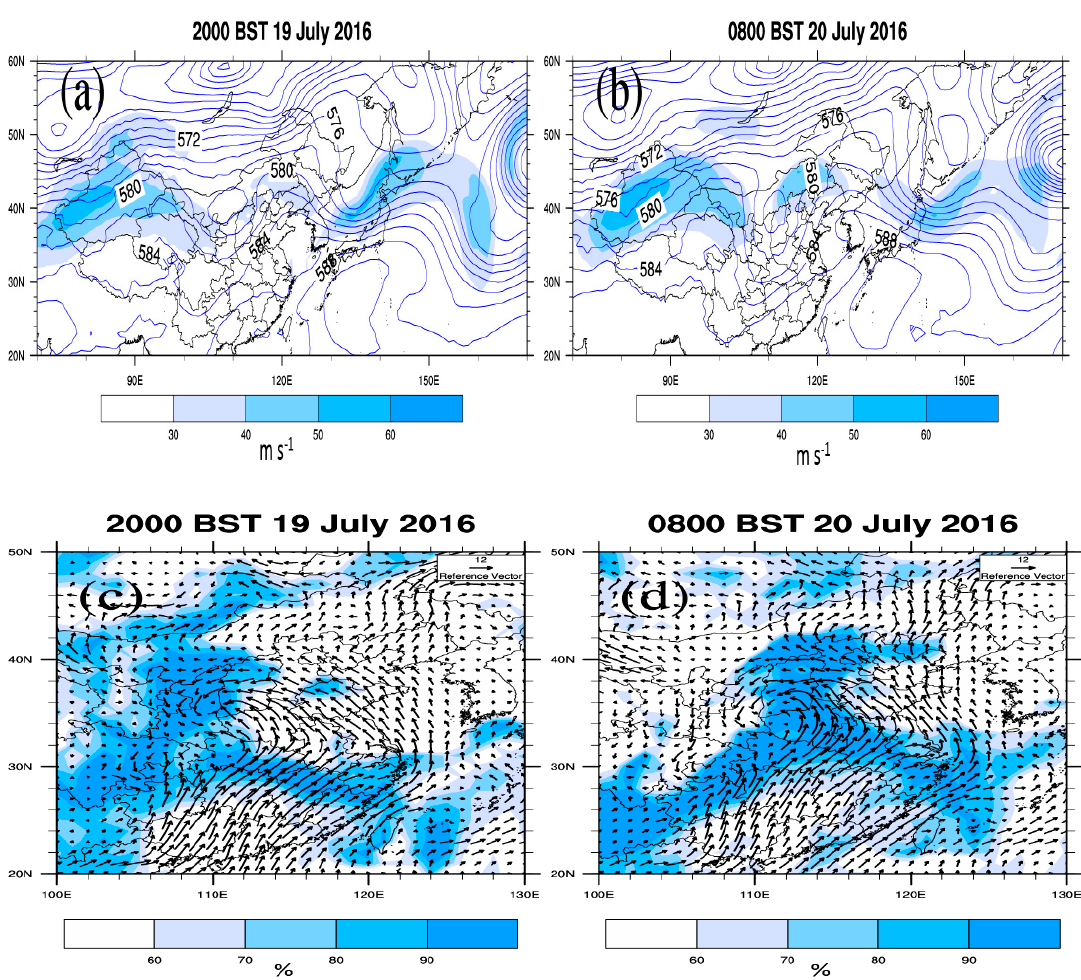
Figure 2. Upper-level jet stream at the 200 hPa level (shaded), unit: m s -1 and potential height at the 500 hPa level (blue lines), unit: dagpm at ( a ) 2000 BST on July 19 (B: Lake Baikal, H: Hetao region), and ( b ) 0800 BST on July 20. Wind field at the 850 hPa level (arrow), unit: m s -1 and relative humidity at the 700 hPa level (shaded), unit:% at ( c ) 2000 BST on July 19, and ( d ) 0800 BST on July 20.